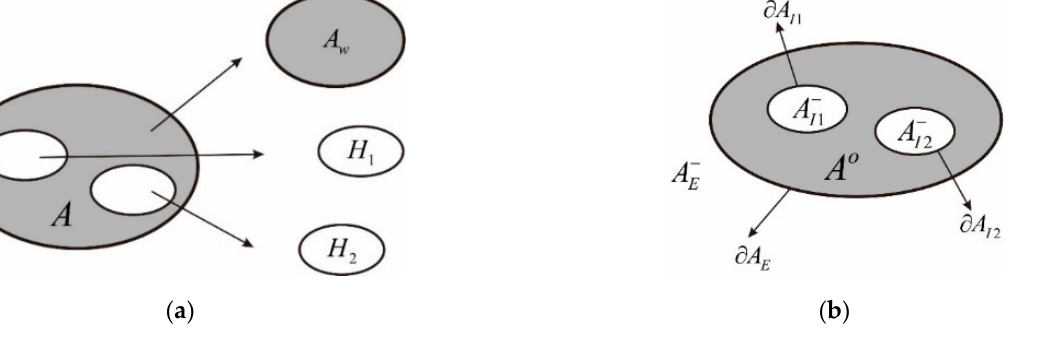
Figure 1. Components in different kinds of definitions of regions with holes: ( a ) components in the indirect expression definition; ( b ) components in the direct expression definition.